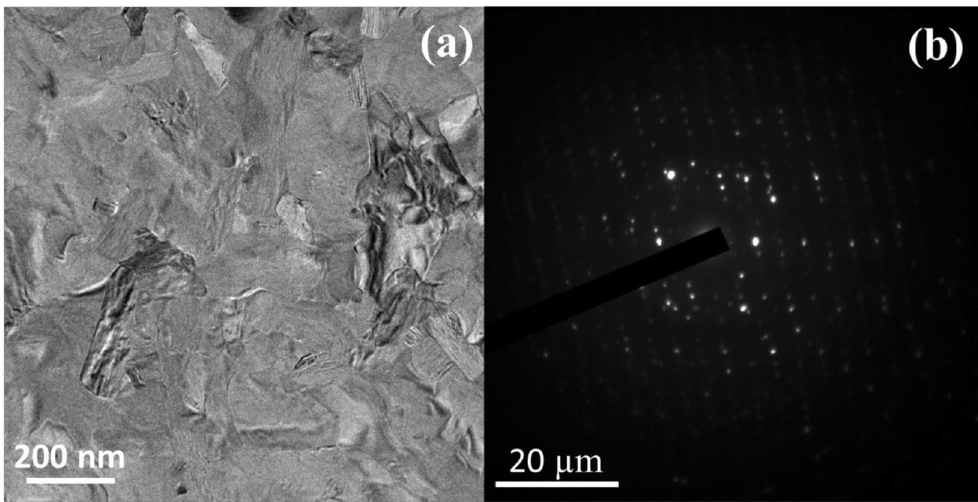
Figure 5. ( a ) The bright field TEM image and ( b ) the SAED pattern of the undoped ZnSb film annealed at 350 °C.